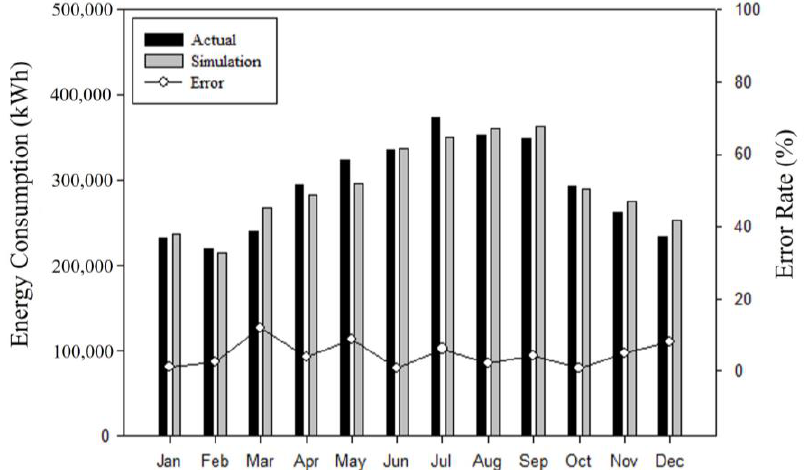
Figure 9. The comparison of energy consumption between the measurement and simulation.